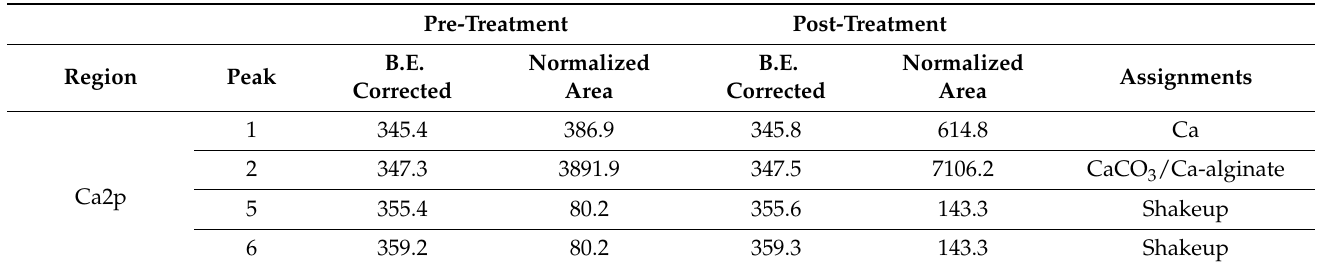
Figure 5. Curve fitting of Ca2p regions pre ( left ) and post ( right ) glycoalkaloids application. Table 3. Peak assignment, corrected BE, and normalized area for the Ca2p region.